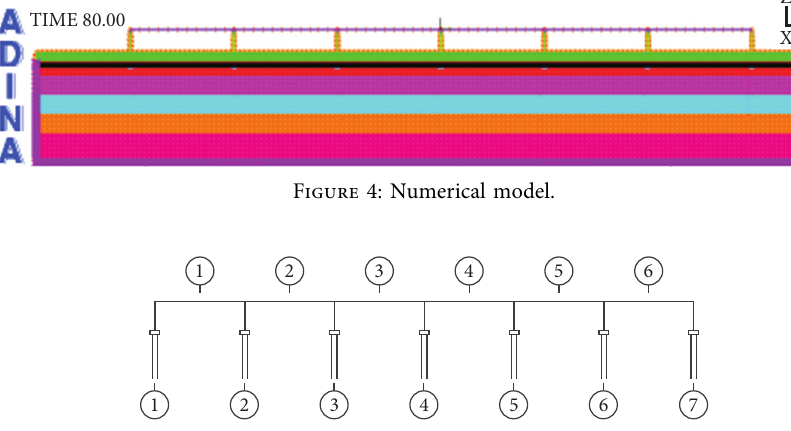
Figure 5: Schematic diagram of component number. Table 3: Seismic records